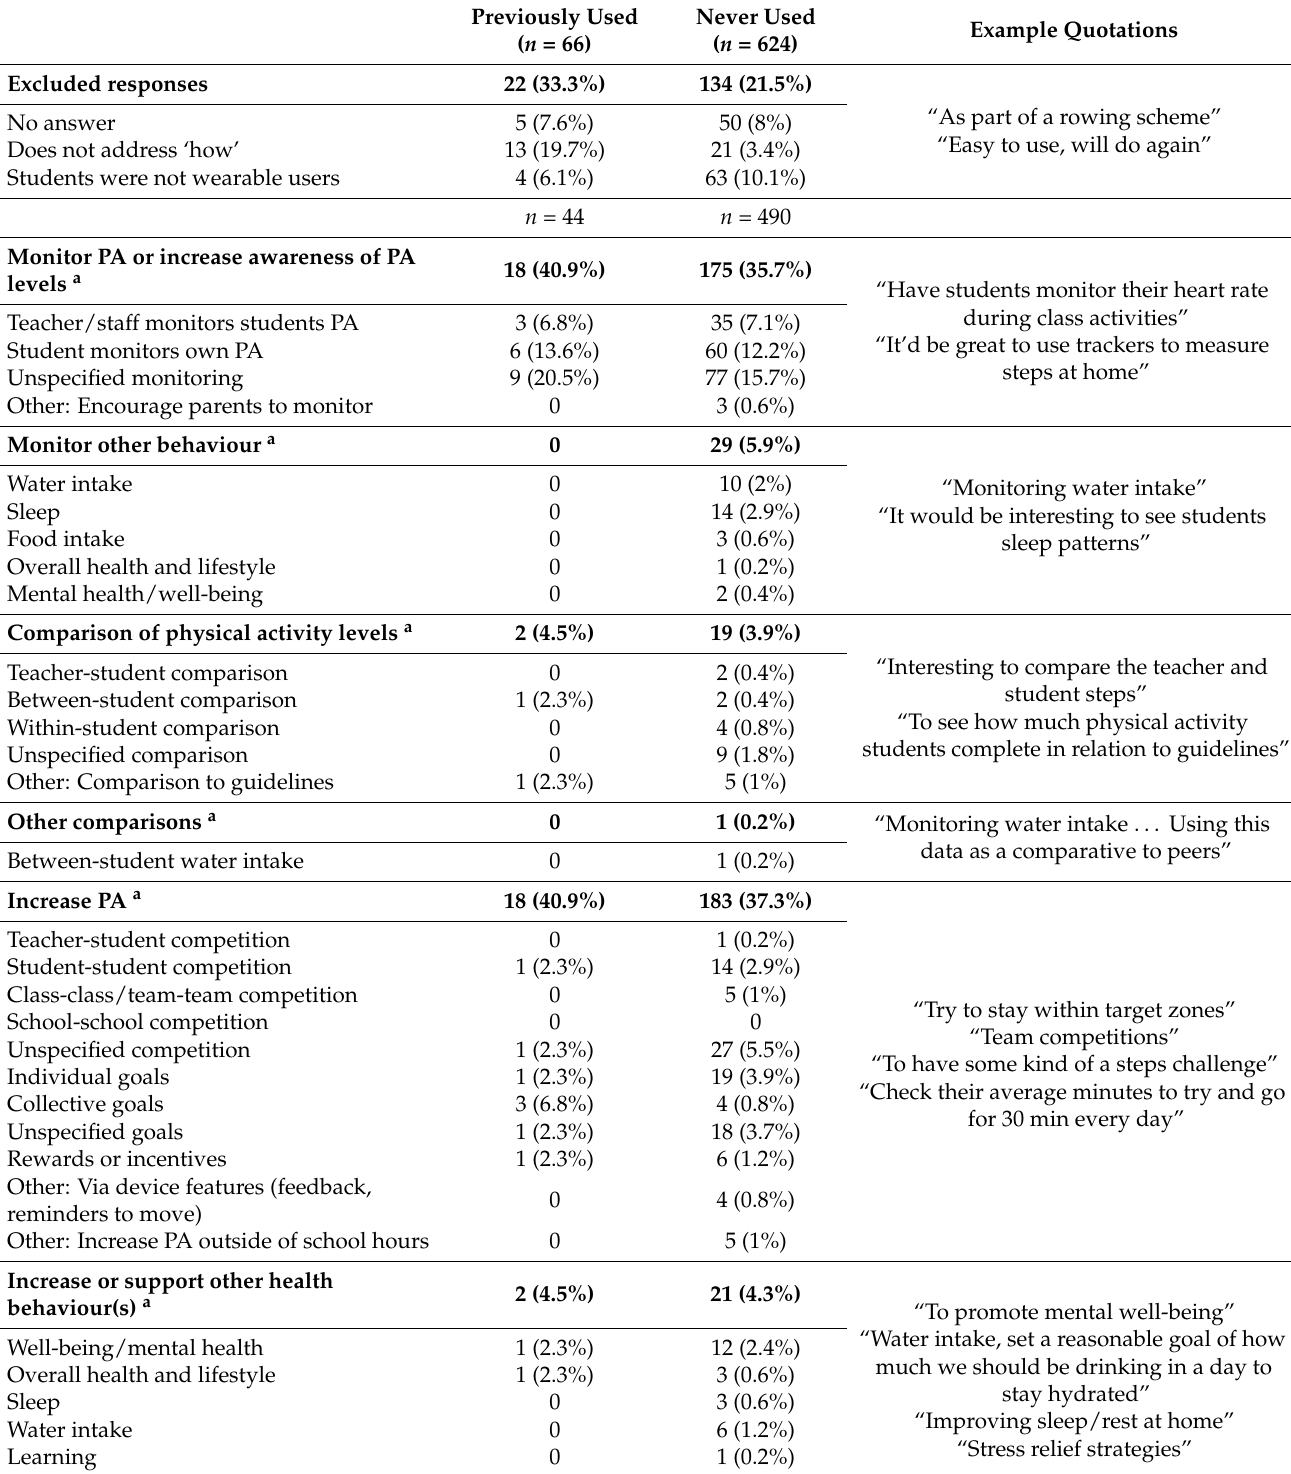
Table 4. How school staff are willing to implement the use of wearables in schools, n (%). Previously